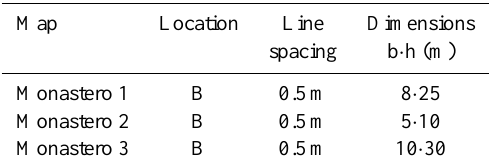
Table 2. Magnetic maps and GPR datasets carried out in “Monastero”